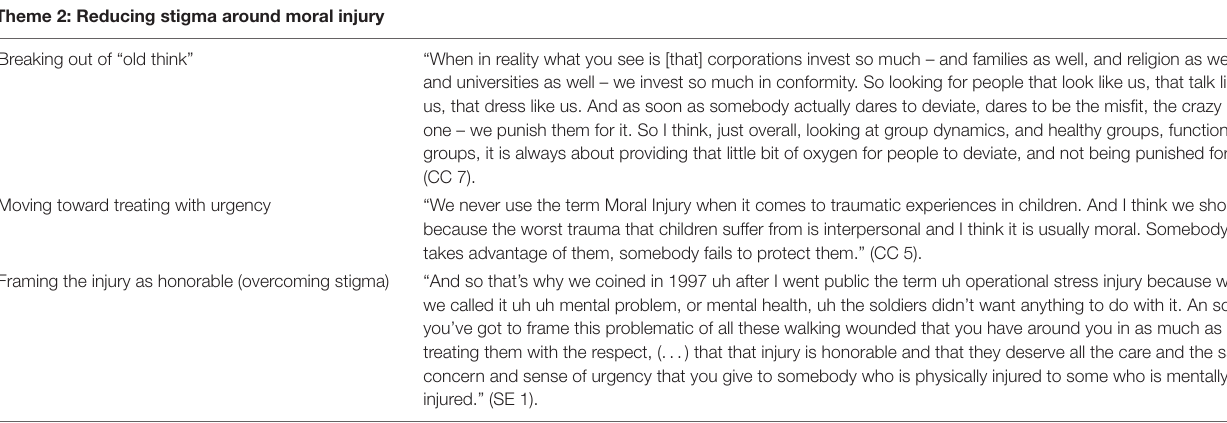
TABLE 4 | Additional supporting quotes for the theme “reducing stigma around moral injury.” Theme 2: Reducing stigma around moral injury Breaking out of “old think”